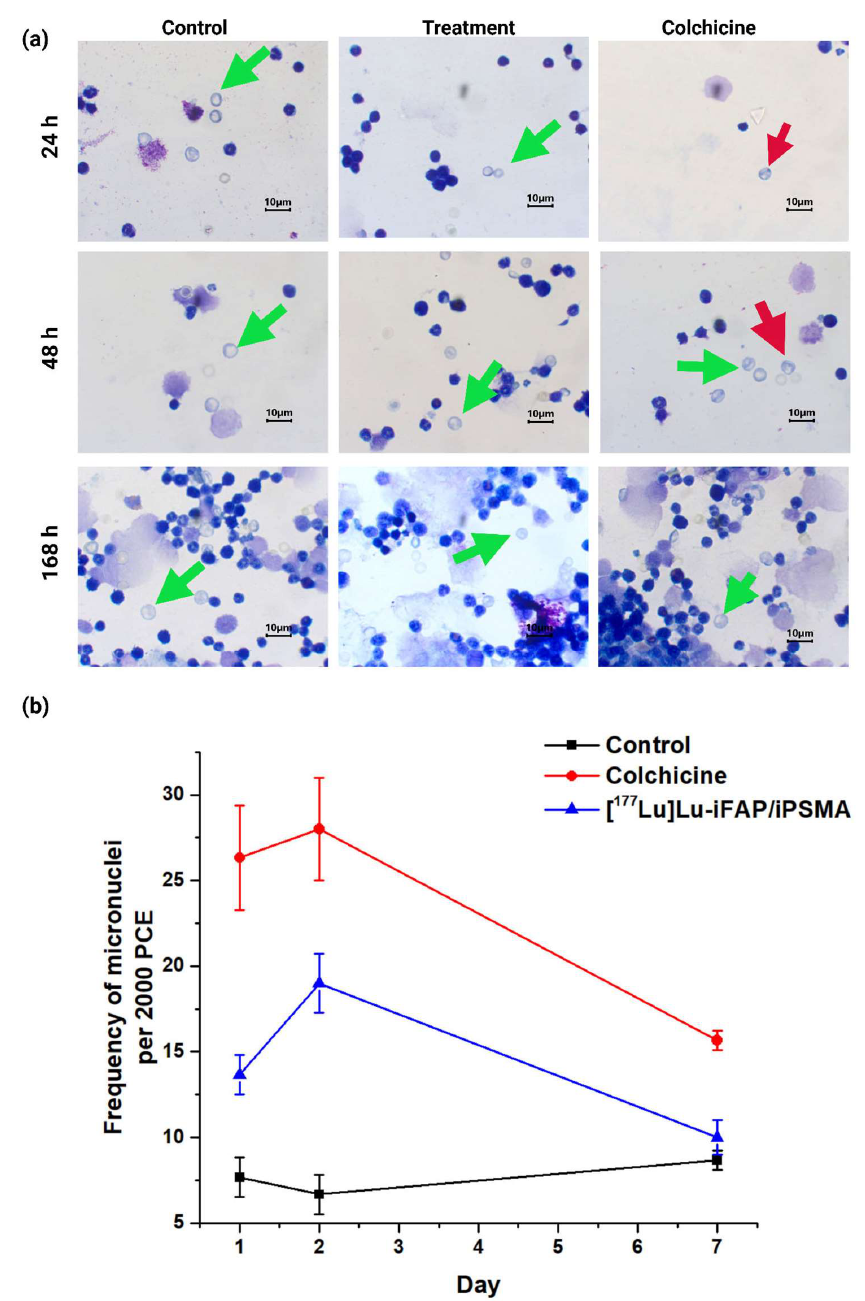
Figure 7. ( a ) Light micrographs (Giemsa-Wright staining at 1000× magnification of) of bone marrow cells from healthy mice at 24, 48, and 168 h after i.v. administration of [ 177 Lu]Lu−iFAP/iPSMA nanoparticles (treatment), colchicine (1 mg/kg) (positive control), and untreated mice (negative control). Green arrows show polychromatic immature erythrocytes, and red arrows indicate polychromatic erythrocytes (PCE) with micronuclei. ( b ) Micronucleus count values in immature bone marrow erythrocytes at 1, 2, and 7 d. Data are presented as mean ± standard deviation of three independent experiments. Non-significant difference ( p > 0.05) between control and treatment at 7 d.